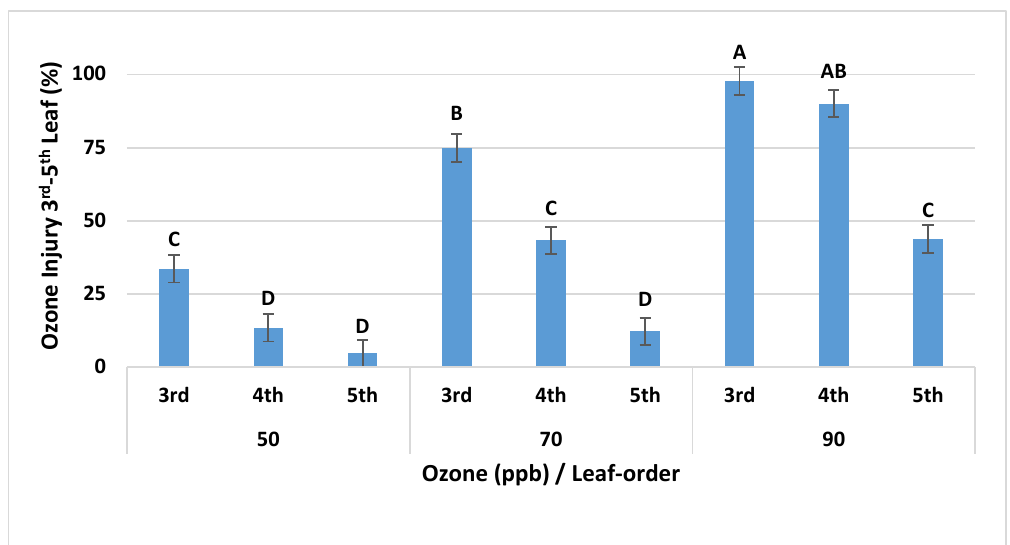
Figure 8. Interplay of leaf-order and O 3 treatment on average O 3 injury (±SE) on the third – fifth leaf of rust near-universal susceptible genotypes, exposed for 14 days (12 h/day), at 25 °C and 50% RH, in OPECs. Injury was visually estimated, under constant light conditions on a 0 – 100% scale. Values are means (±SE) statistically separated using Tukey-Kramer adjustment for multiple comparisons. Means marked with the same letter are not significantly different at α = 0.05.